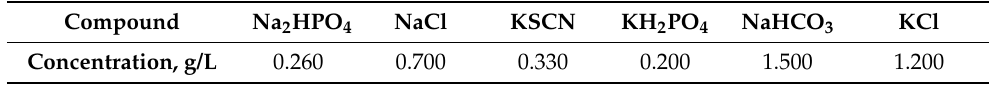
Table 4. SBF —Artificial saliva chemical